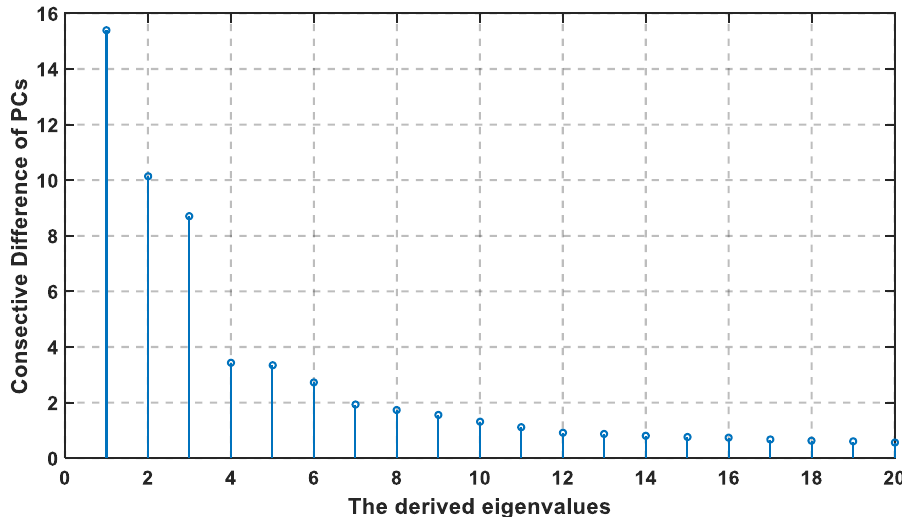
Figure 4. Derived Eigenvalues in Large-Scale Experiment.